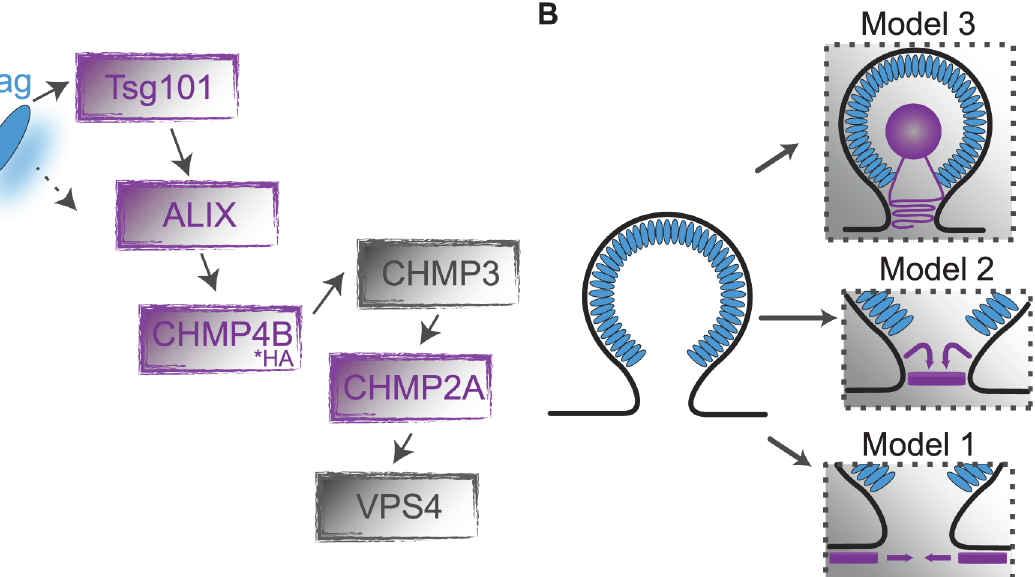
Fig 1. Gag-ESCRT Interactions. ( A ) A simplified schematic of the interaction scheme between HIV-1 assembly sites and the ESCRT recruitment pathway. The constructs analyzed in this study are highlighted in purple. ( B ) An overview of the proposed models of membrane scission where ESCRT factors interact either via external constriction from the cytosol (cytosolic model, Model 1), via internal constrict of the budding virus in the neck region (neck model, Model 2) or from within the bud (bud model, Model